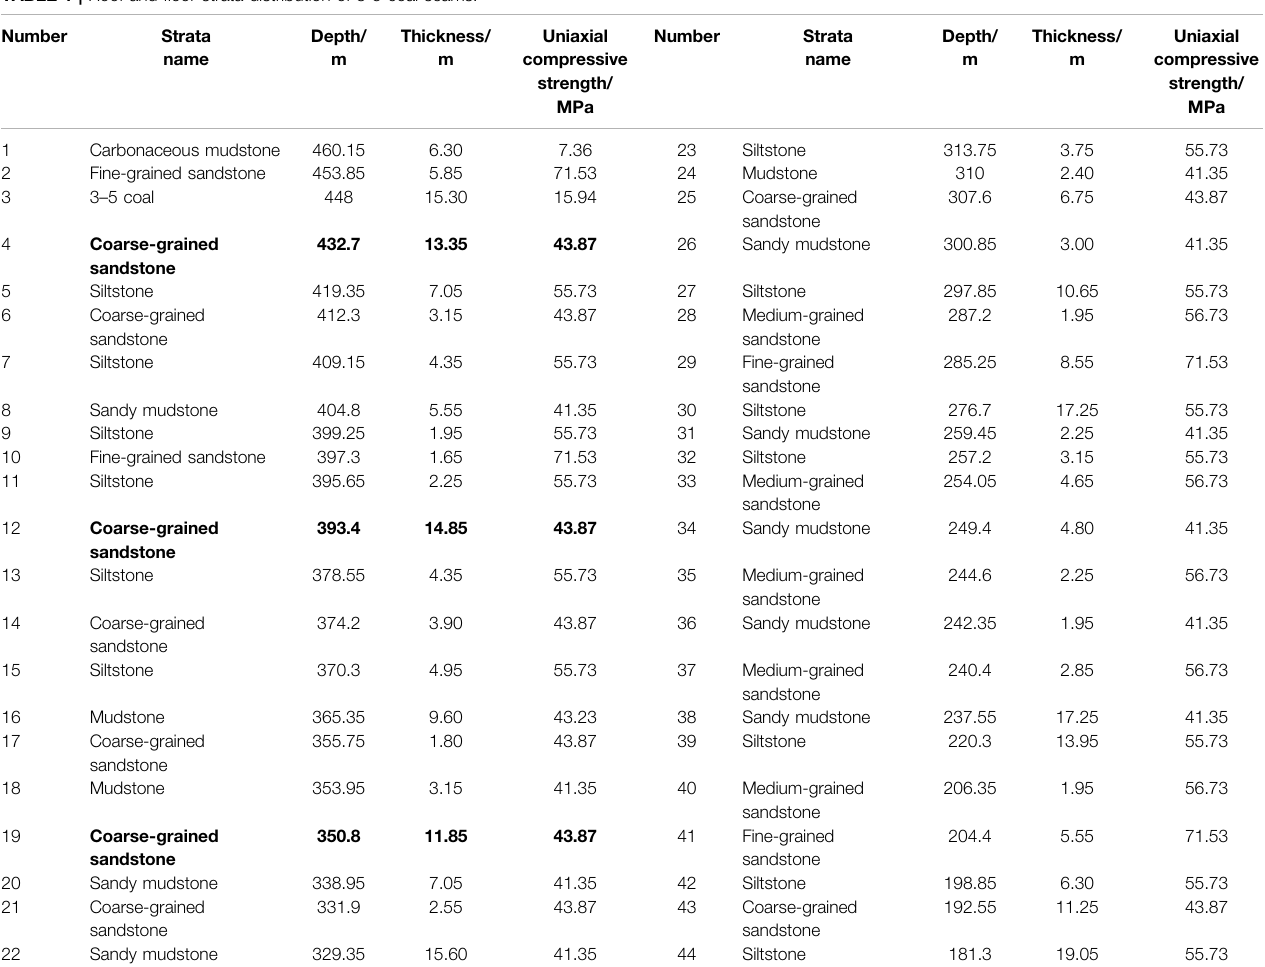
TABLE 1 | Roof and fl oor strata distribution of 3-5 coal